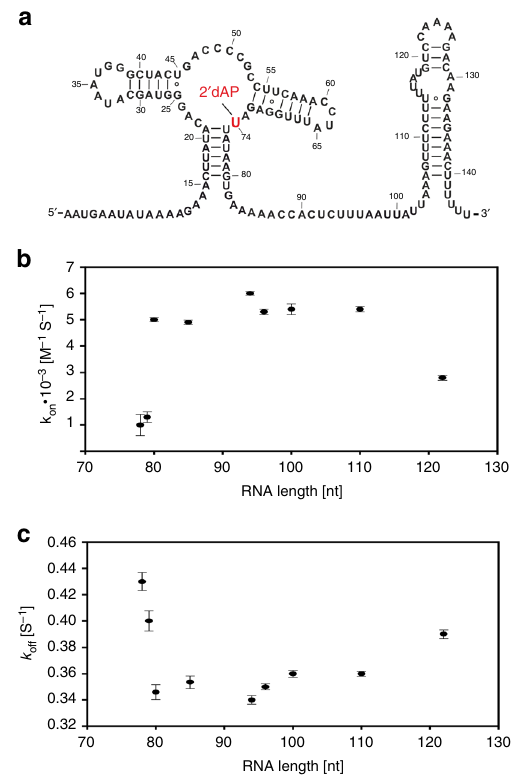
Fig. 4 Ligand binding kinetics. a Secondary structure of dGsw C74U highlighting the C to U mutation at position 74 in red to accommodate the fl uorescence ligand analog 2-aminopurine-2 ′ deoxyriboside (2 ′ dAP). b Final k on and c k off rates of 2 ′ dAP binding to dGsw C74U derived from data shown in Supplementary Fig. 4 and Table 3 at varying transcript lengths. Errors correspond to the s.d. of the fi